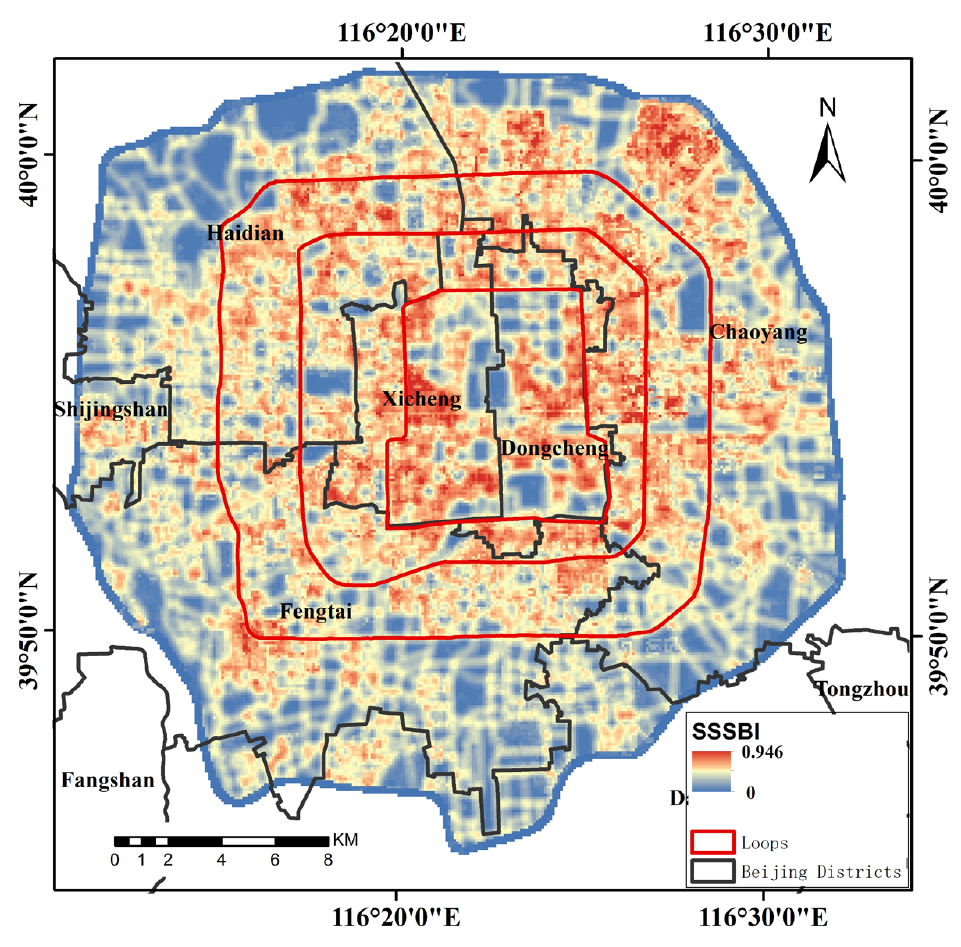
Figure 10. Spatial distributions of SSSBI.